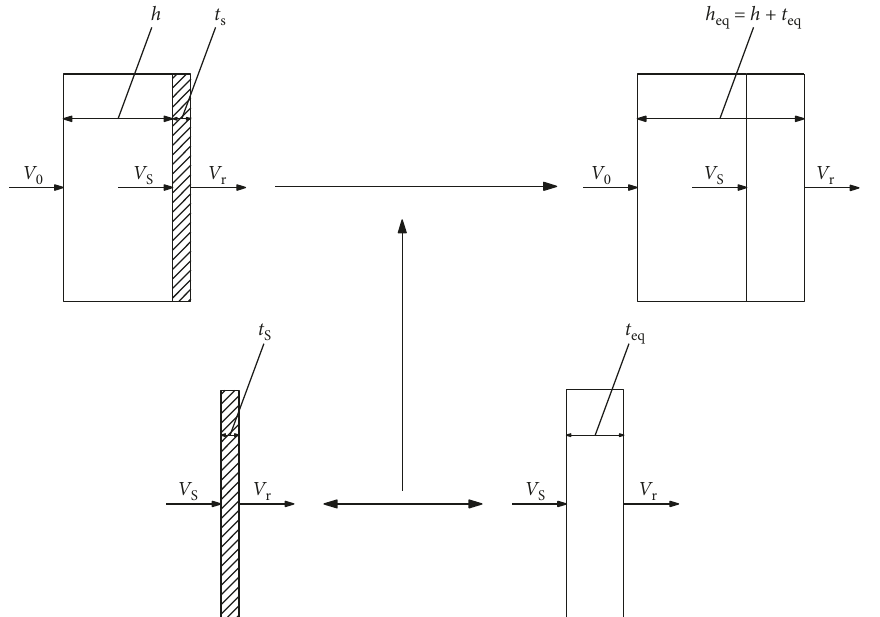
Figure 1: Equivalence principle between a rear steel liner and a concrete matrix.